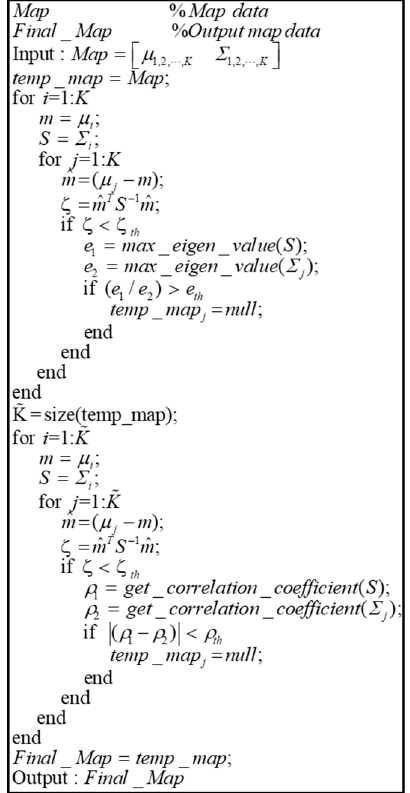
Figure 17. Pseudocode of algorithm for removal of overlapped probability distributions.